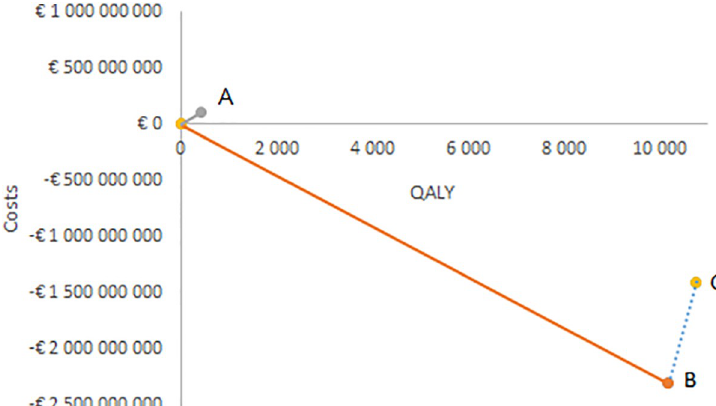
Fig 5. Incremental cost-effectiveness ratios illustrated on the cost-effectiveness